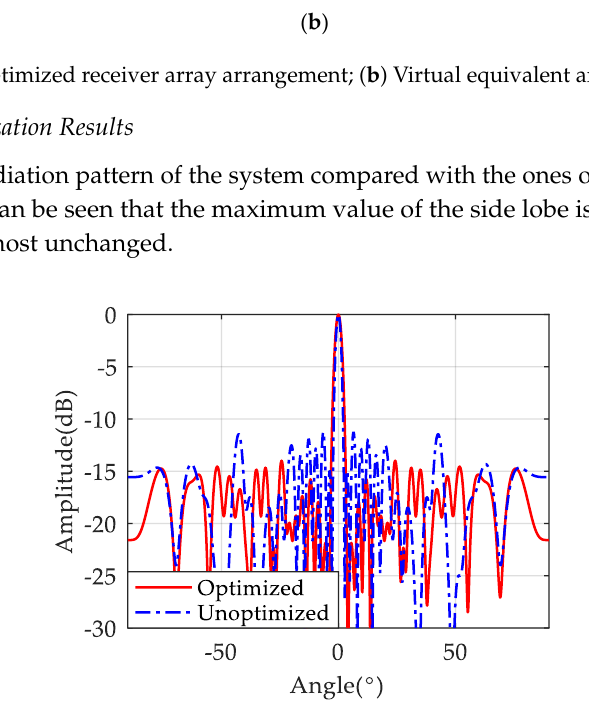
Figure 4. The radiation pattern of optimized and un-optimized array.